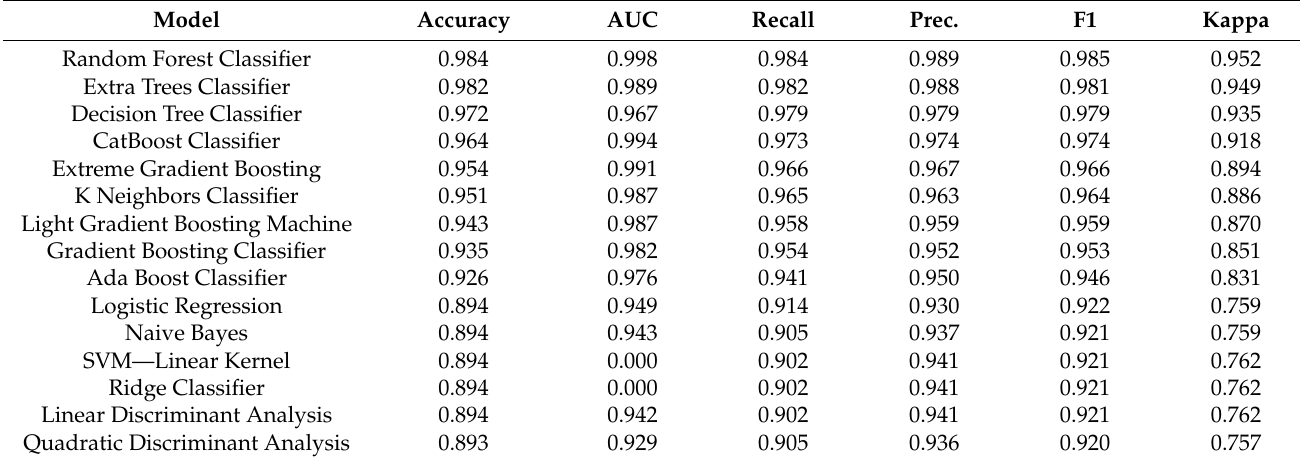
Table A2. Classification metrics for the Hybrid model.